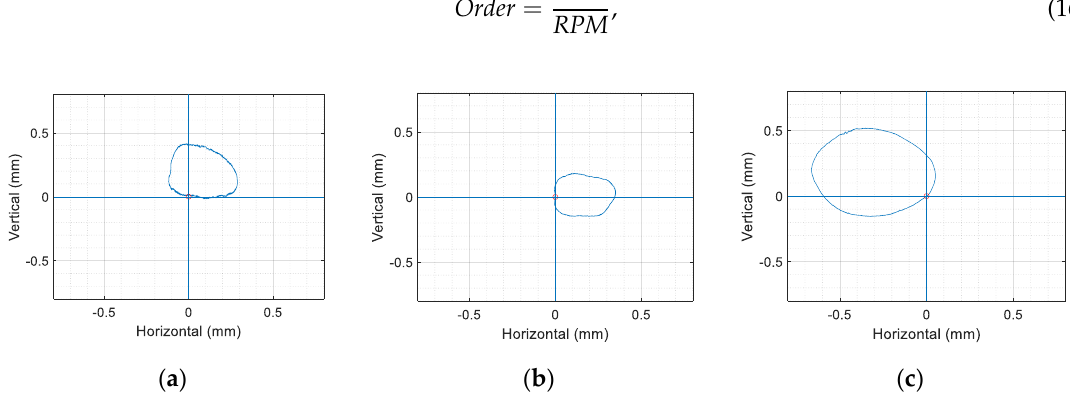
Table 4. The electromotive force obtained from change in speed and dipole magnet current . The Current Supplied to the Magnetic Coil Figure 16. The comparison of the movement characters of the rotating coil at 60 RPM: ( a ) shaft orbit Speed (RPM) at DE side; ( b ) shaft orbit at center; ( c ) shaft orbit at NDE side.